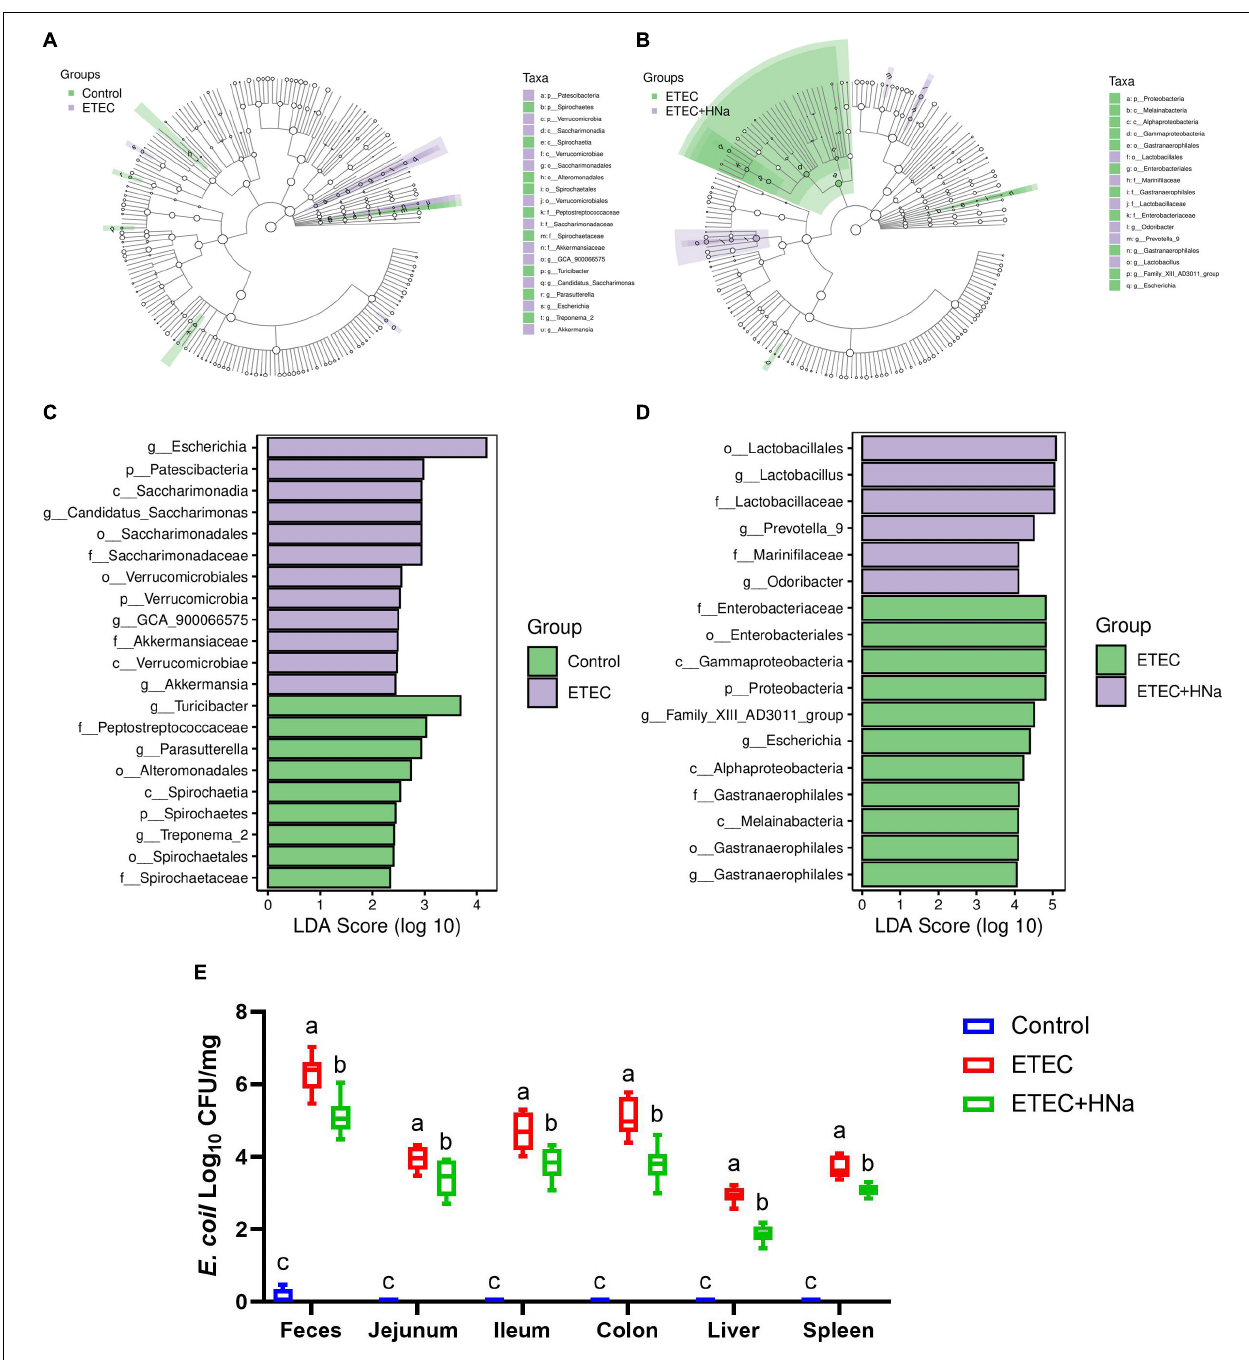
FIGURE 6 | Effect of sodium humate on the diversity of intestinal microbiota of ETEC K88-infected mice. Control vs ETEC (A) and ETEC vs ETEC + HNa (B) groups taxonomic cladogram of LEfSe analysis. Different colors indicate the enrichment of the biomarker taxa in different groups. The circle from inside to outside means the rank from kingdom to species, and the circle size represents the taxa abundance in the community. Control vs ETEC (C) and ETEC vs ETEC + HNa (D) linear discriminant analysis (LDA) scores for different taxa abundances. (E) The number of E. coli in jejunal mucosa, ileal mucosa, colonic mucosa, feces, liver, and spleen ( n = 10). All of the data are expressed as the mean ± SEM. Different superscript lowercase letters within each group indicate significantly different ( P < 0.05).